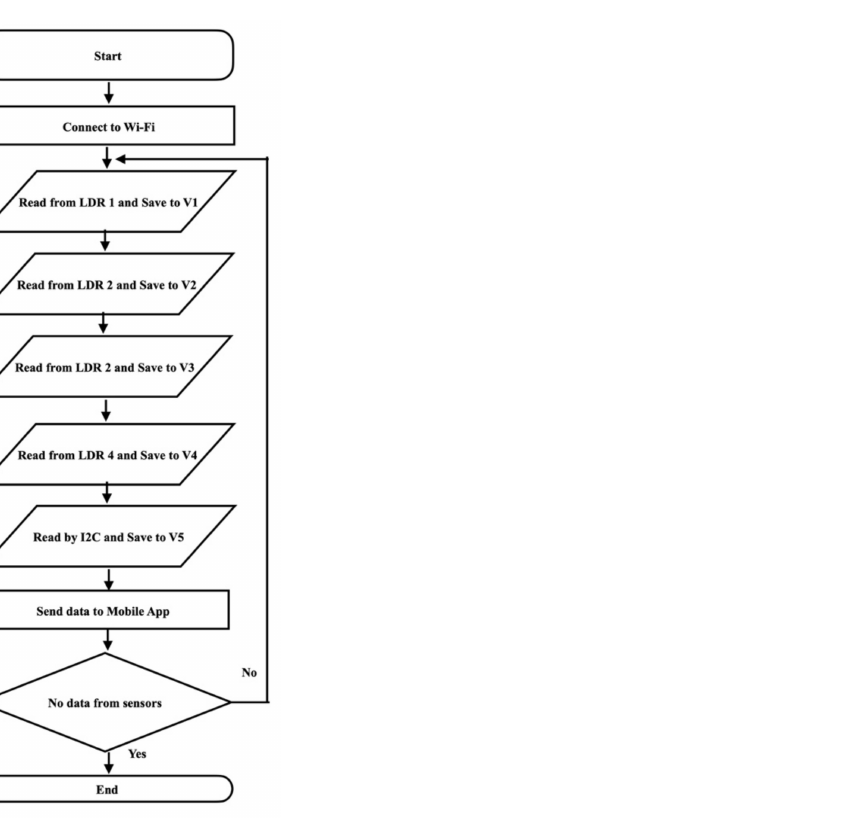
Figure 8. Part of Guidance Landing System (GLS) circuit connections diagram.